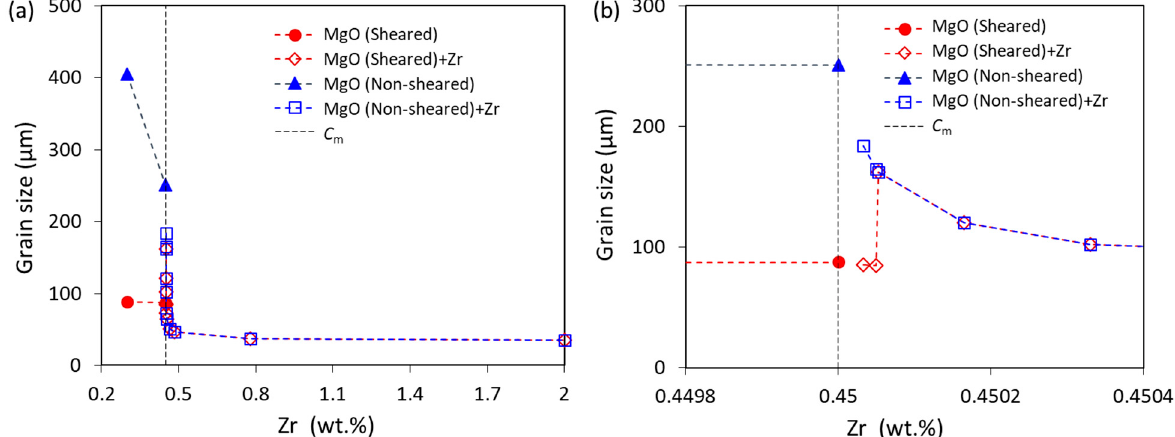
Figure 7. ( a ) The calculated grain size of Mg-Zr alloys with and without intensive melt shearing at a cooling rate of 3.5 K/s; and ( b ) the enlarged part of ( a ) with a Zr concentration near C m . The N 0 of Zr particles is equivalent to the extra Zr (exceeding 0.45 wt.%) based on the size distribution of Zr in the Mg-33Zr grain refiner.